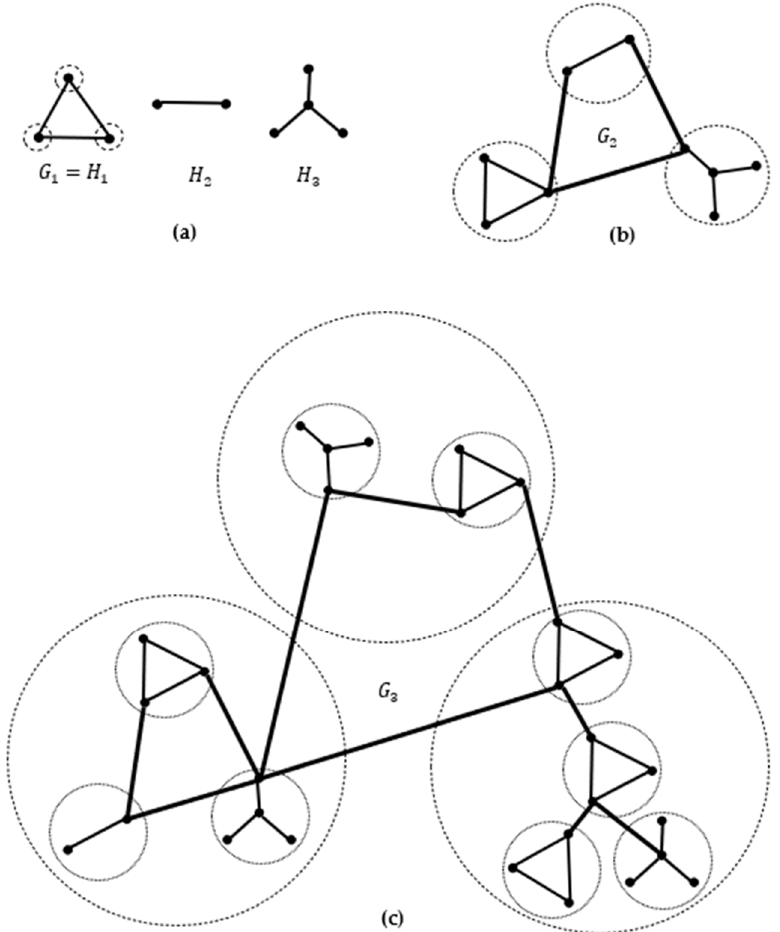
Figure 4. G 3 generated by a set H : ( a ) set of seeds { H 1 , H 2 , H 3 } ; ( b ) prefractal graph G 2 ; ( c ) prefractal graph G 3 , small circles indicate new seeds, large circles indicate seeds of the second stage.